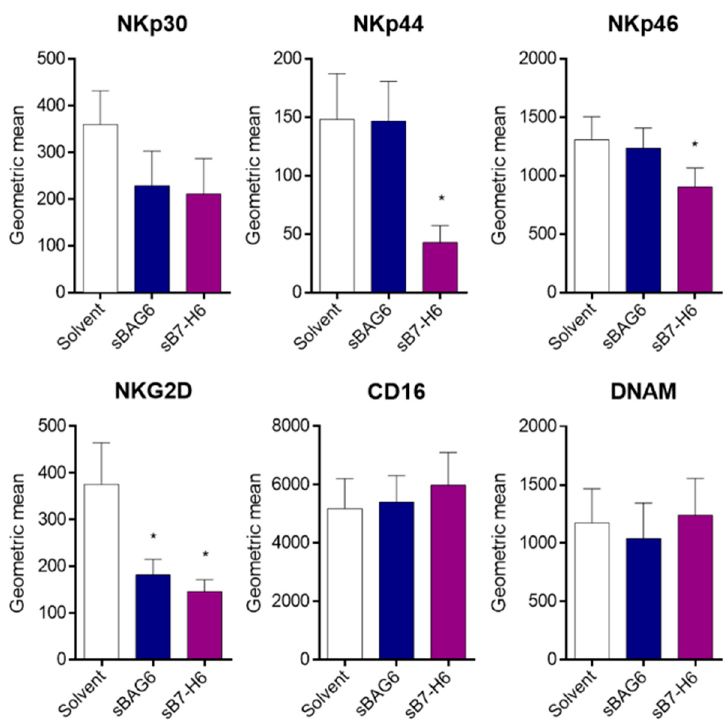
Figure 4. Reduced NK cell marker expression after treatment with soluble protein. NK cells were treated with sBAG6 or sB7-H6 for 24 h before cells were collected and NK cell marker expression was measured. Data are the mean of four to eight experiments ± SEM. Statistical significance was calculated using Wilcoxon test, * p < 0.05.